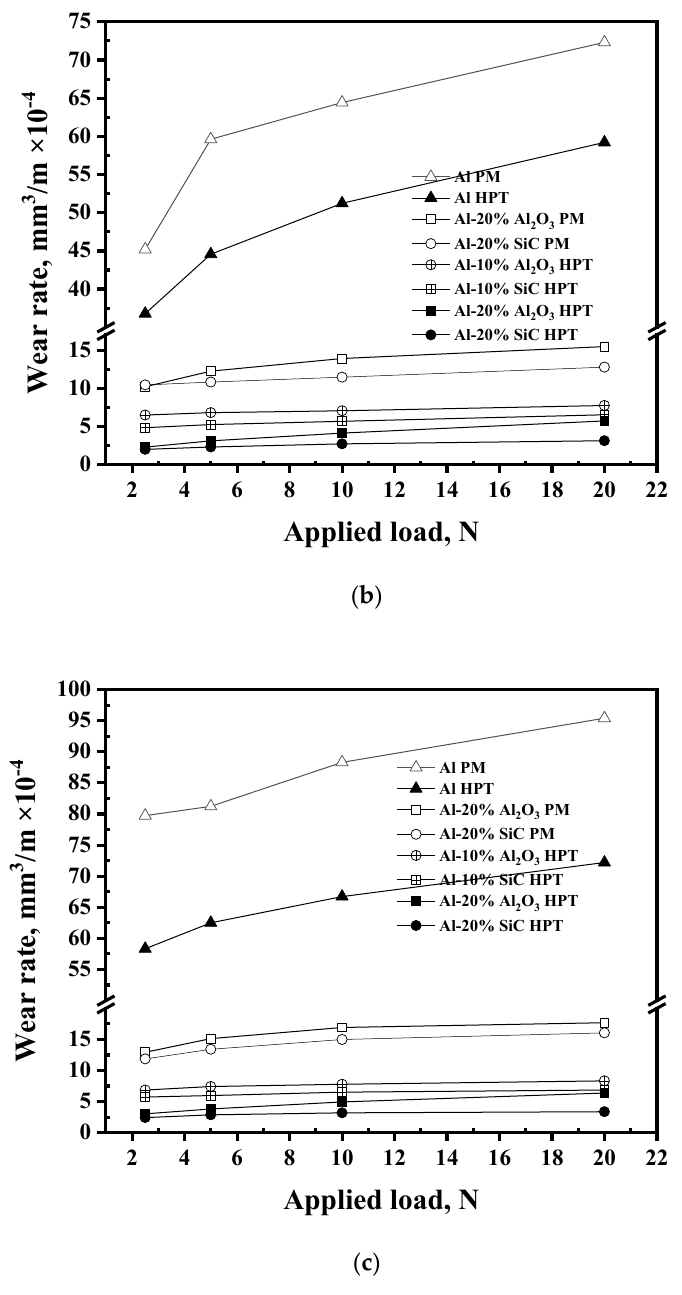
Figure 2. The wear rate curves of the different samples under different applied loads and sliding distances of ( a ) 315, ( b ) 630, and ( c ) 1260 m.